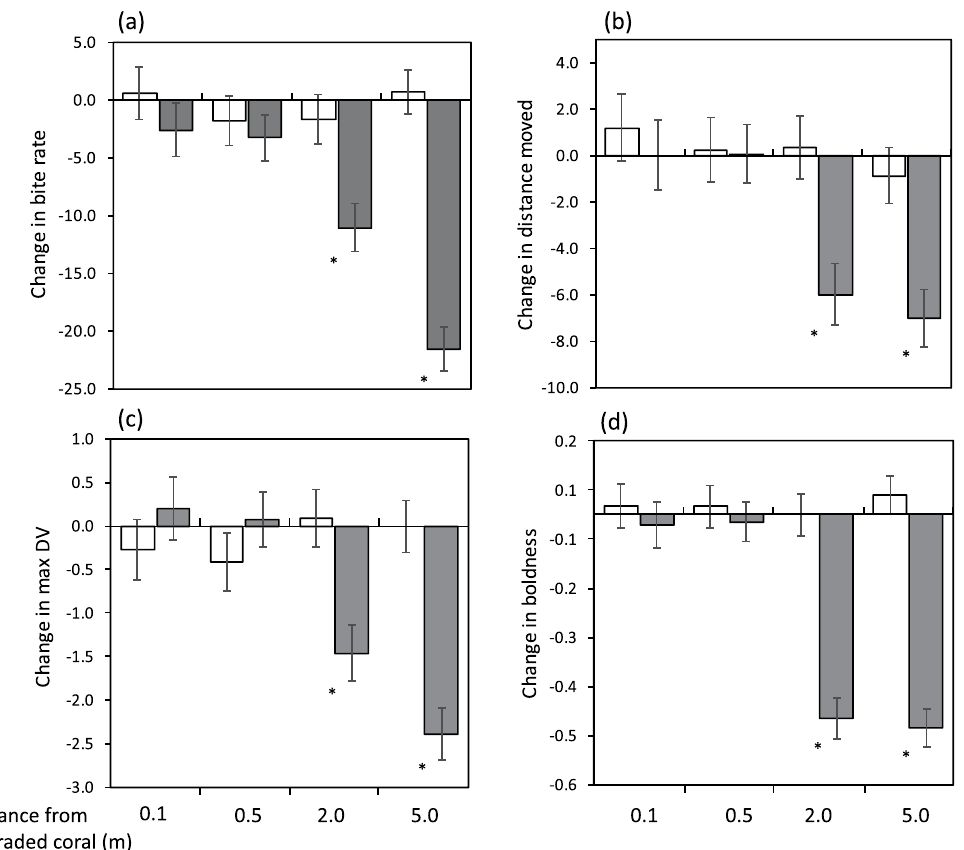
Figure 2. Effect of distance down-current from degraded coral on the detection of chemical alarm cues by Pomacentrus amboinensis on live coral patch reefs. Fish were exposed to either saltwater (white) or alarm odour (grey) by a tube up-current of the patch reef and their change in behaviour recorded over 3 min (before and after cue) as: ( a ) bite rates, ( b ) total distance moved, ( c ) maximum distance ventured from shelter, ( d ) boldness index (expressed as a continuous scale from 0 = shy to 3 = bold, see text for details). Asterisks represent significant differences between SW and alarm odour response by planned comparison. N (left to right) were: 11, 12, 12, 15, 10, 14, 13,